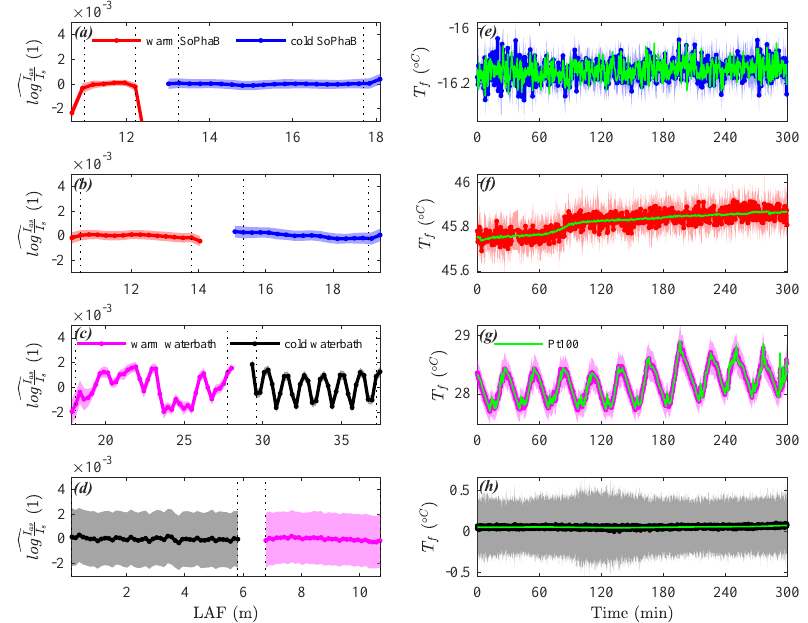
Figure 4. Solid-Phase Bath (SoPhaB) and waterbath performance from the constant-temperature field evaluations: Temporal average (solid line with markers) and ± standard deviation (band) of the spatial perturbation of the ratio of Raman backscatter intensities across the fiber-optic cable reference sections ( a – d ), and time series of the spatially averaged (solid line with markers) ± spatial standard deviation (band) fiber-optic and reference (Pt100) temperatures ( e – h ) for ( a , e ) Arctic polarnight, ( b , f ) Urban summer, ( c , g ) Arctic pier, and ( d , h ) Grass summer. The vertical dotted lines mark the beginning and end of the reference section over which the spatial average was